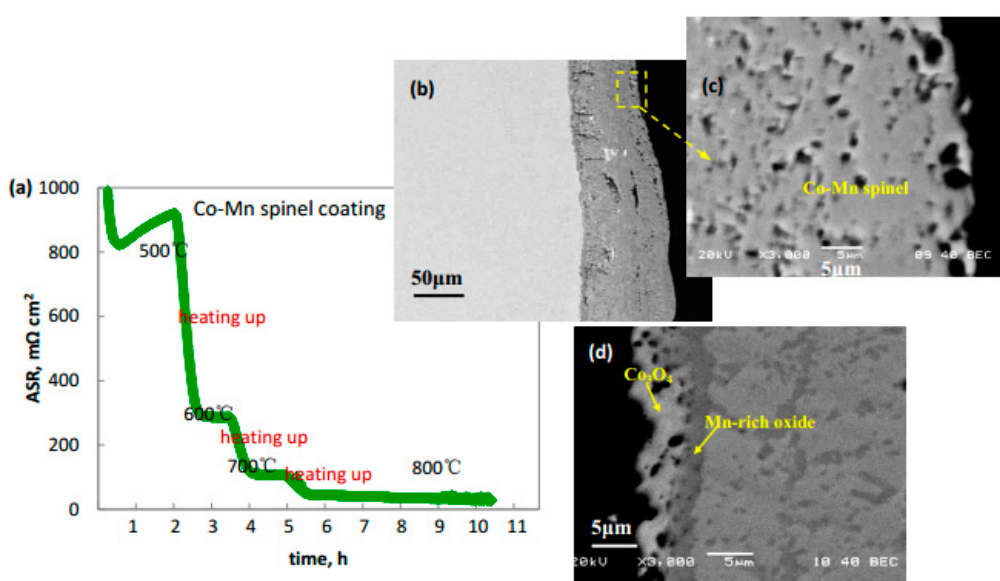
Figure 4. ( a ) Area specific resistance (ASR) of Co-Mn spinel coating with a temperature range of 500–800 ◦ C; ( b ) cross-section morphology of Co-Mn spinel coating; ( c ) a section with Co-Mn spinel scale; and ( d ) a section with Co 3 O 4 oxide.